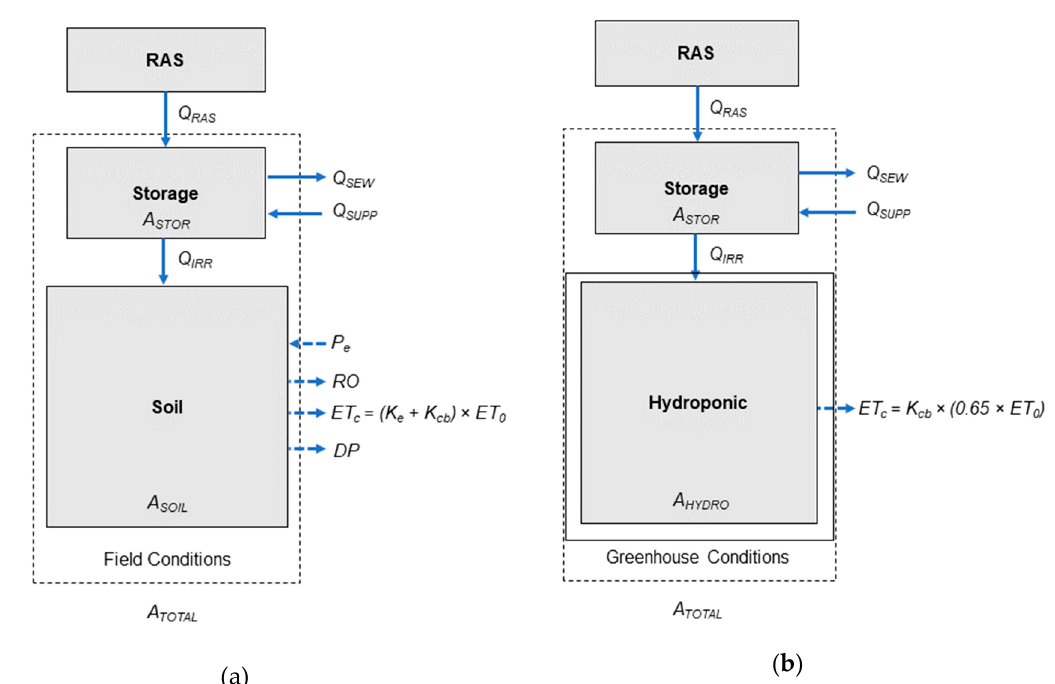
Figure 3. End-of-pipe horticultural reuse scheme (HRS) hydrologic model for ( a ) SOIL-FIELD and ( b ) HYDRO-GH.